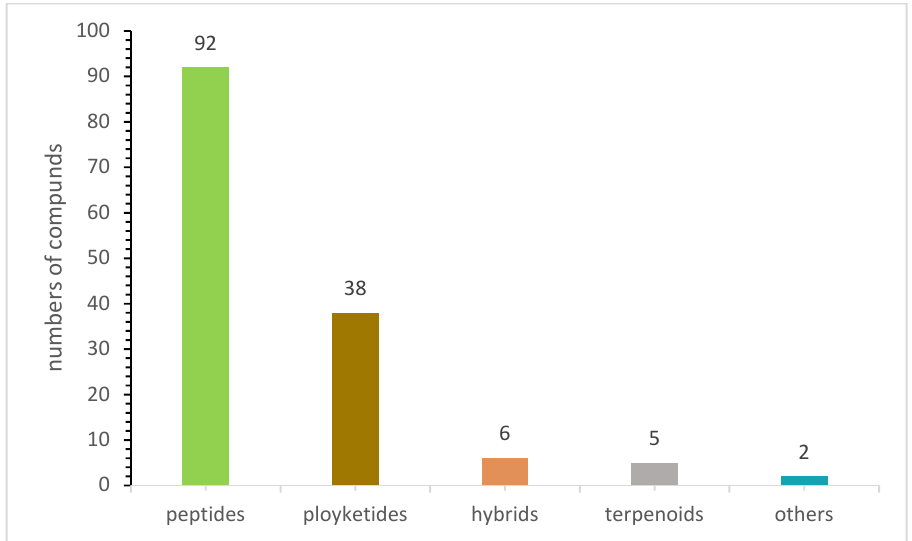
Figure 8. The percentages of the biological activity among sulfur-containing compounds from endophytic fungi.